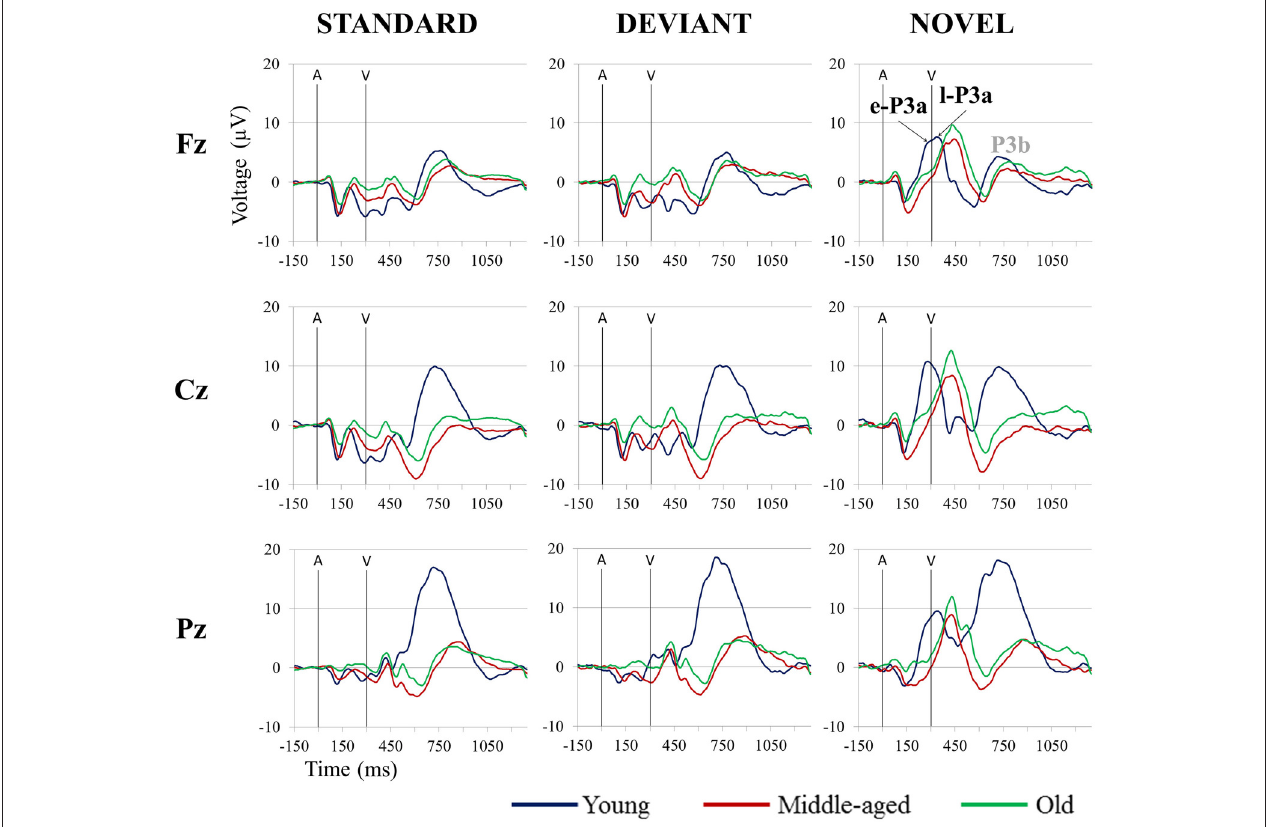
FIGURE 1 | Grand-average event-related potential waveforms at Fz, Cz, and Pz, in the Standard, Deviant, and Novel conditions, for the three age groups (Young, Middle-aged, and Old). In all three age groups, a P3b component elicited by the visual target stimulus was observed in each condition, although this component was not evaluated in this study. A, auditory stimulus; V, visual stimulus. Digital bandpass filter: 0.1–20Hz.